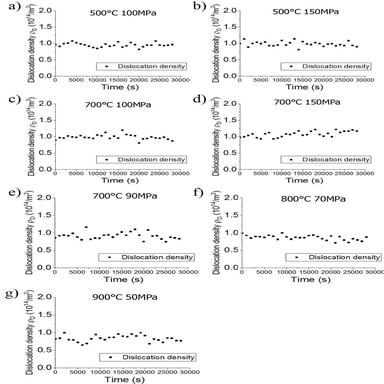
Evolution of dislocation density of Alloy 709 during pseudo-creep test at 500 ◦C under 100 MPa (a), 150 MPa (b). And at 700 ◦C under 100 MPa (c), 150 MPa (d).